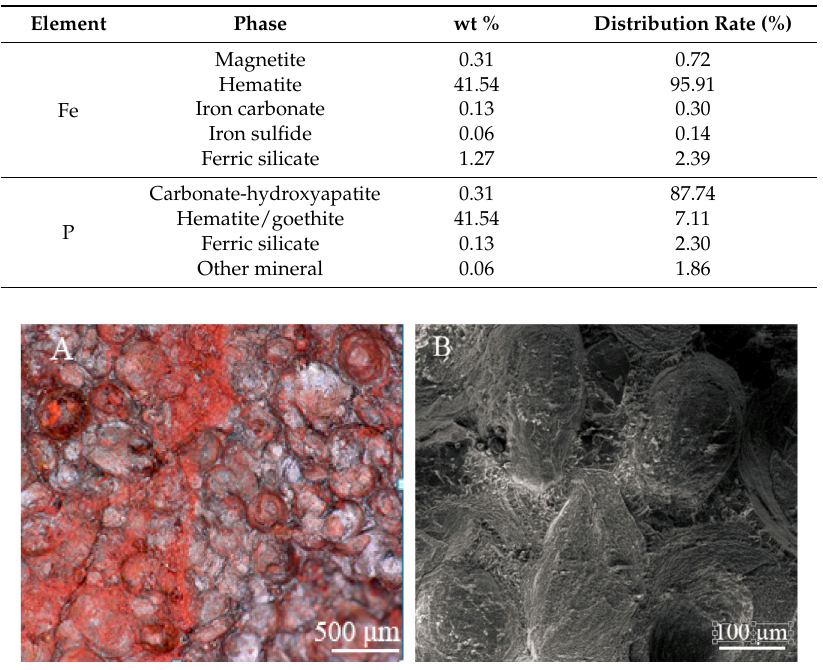
Figure 1. Oolitic hematite. ( A ) optical micrograph; ( B ) SEM